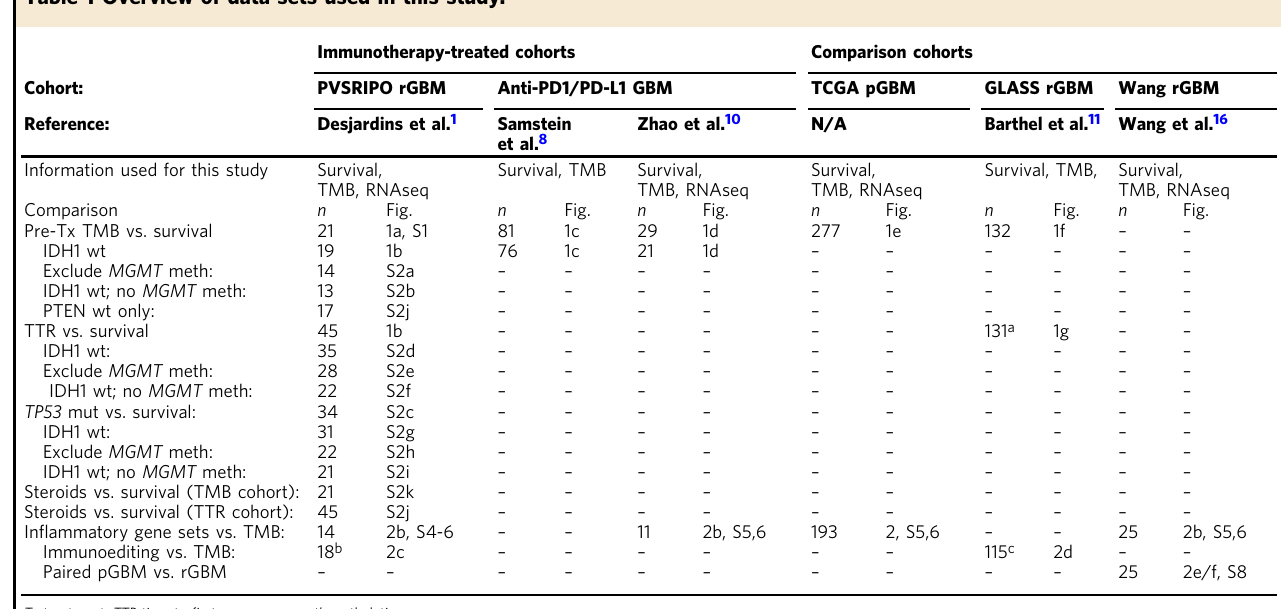
Table 1 Overview of data sets used in this